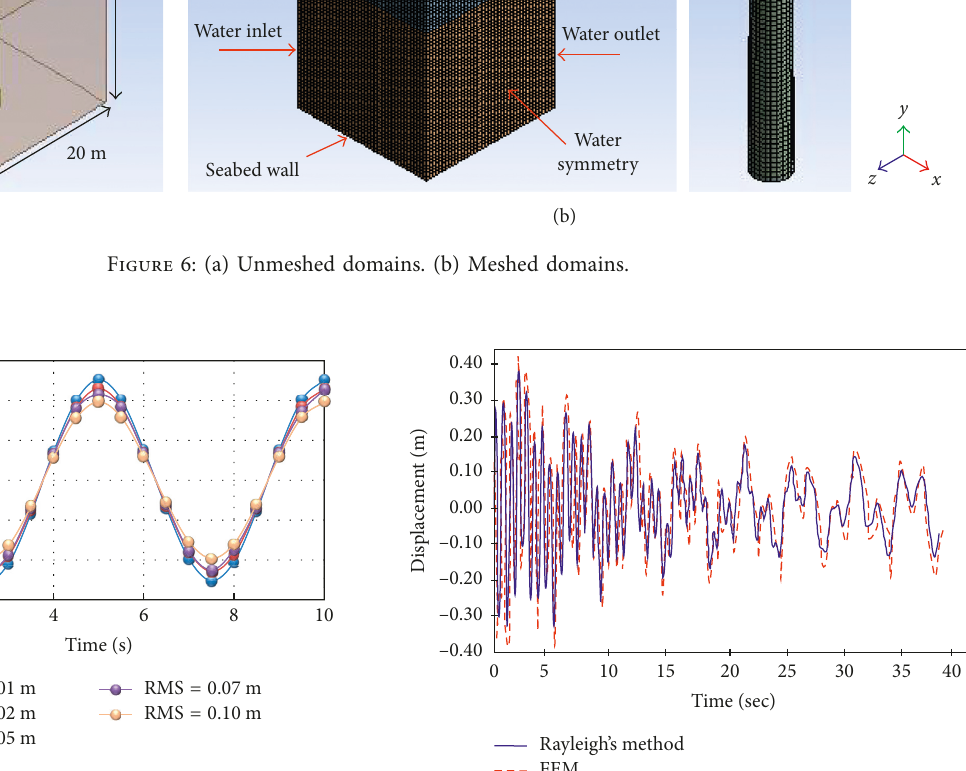
Figure 7: Comparison of hydrodynamic forces for the mesh convergence study. Figure 8: Time-varying displacement values of the wind